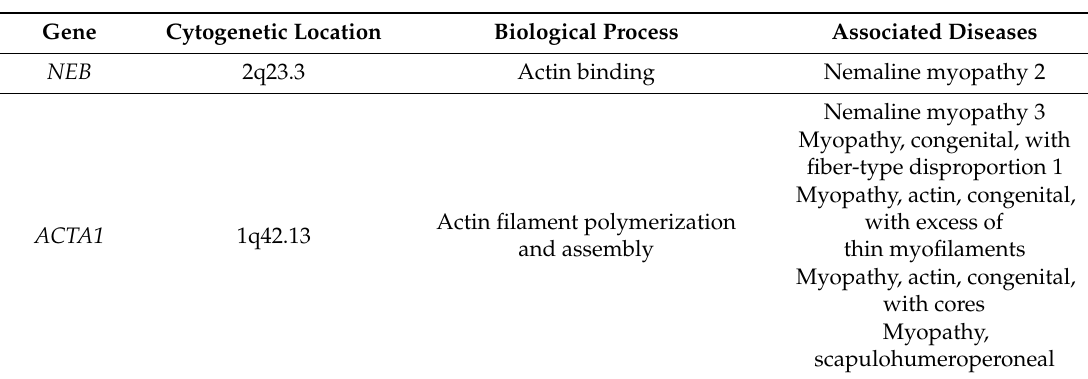
Table 3. Genes implicated in Nemalinic myopathy disease. Gene mutations that cause Nemaline myopathy. Currently, the Myocure platform has di ff erent lines under study with mutations in NEB and ACTA1